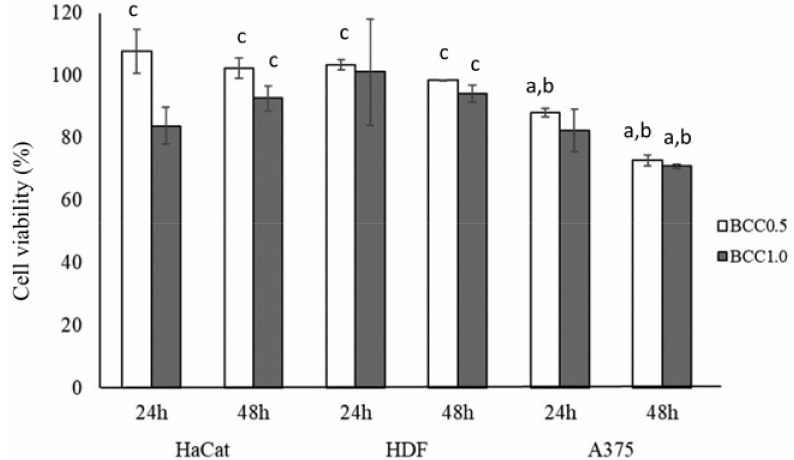
Figure 9. Cell viabilities of HaCat, HDF, and A375 cells after seeding on BCC0.5 and BCC1.0 films for 24 h and 48 h. The values were expressed as mean ± SD ( n = 3). Statistically significant differences in cell viabilities of HaCat, HDF and A375 were compared with the same treatment: a p < 0.05 versus HaCat, b p < 0.05 versus HDF and c p < 0.05 versus